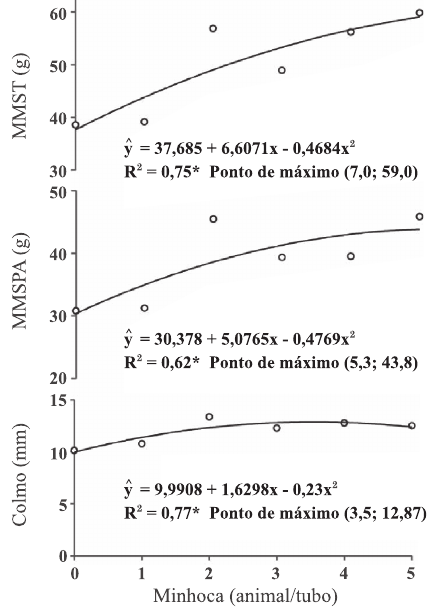
Figura 1. diâmetro do colmo e massas seca da parte aérea (msPA) e total (mst) do milho em resposta a Chibui bari adicionadas ao